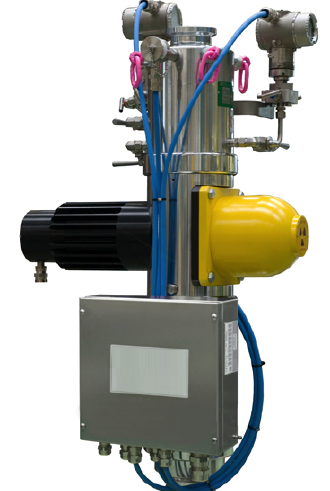
Figure 1. Example of a modular topside Multiphase Flow Meter (MPFM). The vertical pipe is the Venturi tube, where the mixture coming from the well flows. The horizontal tube is the densitometer, while the pressure, impedance and temperature probes are hidden inside the